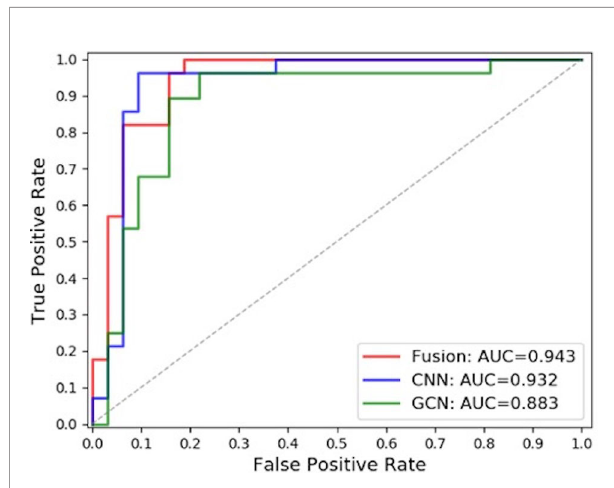
FIGURE 8 | ROC curve